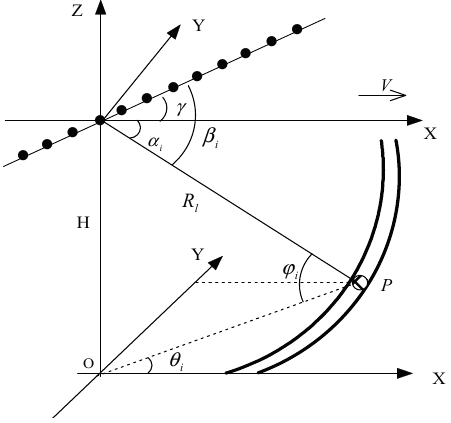
Figure 1. Geometry of non- side looking airborne radar (NSLAR).